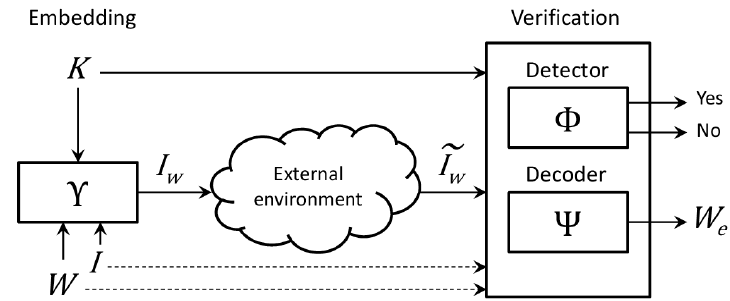
Figure 1. The two phases of a watermarking procedure.